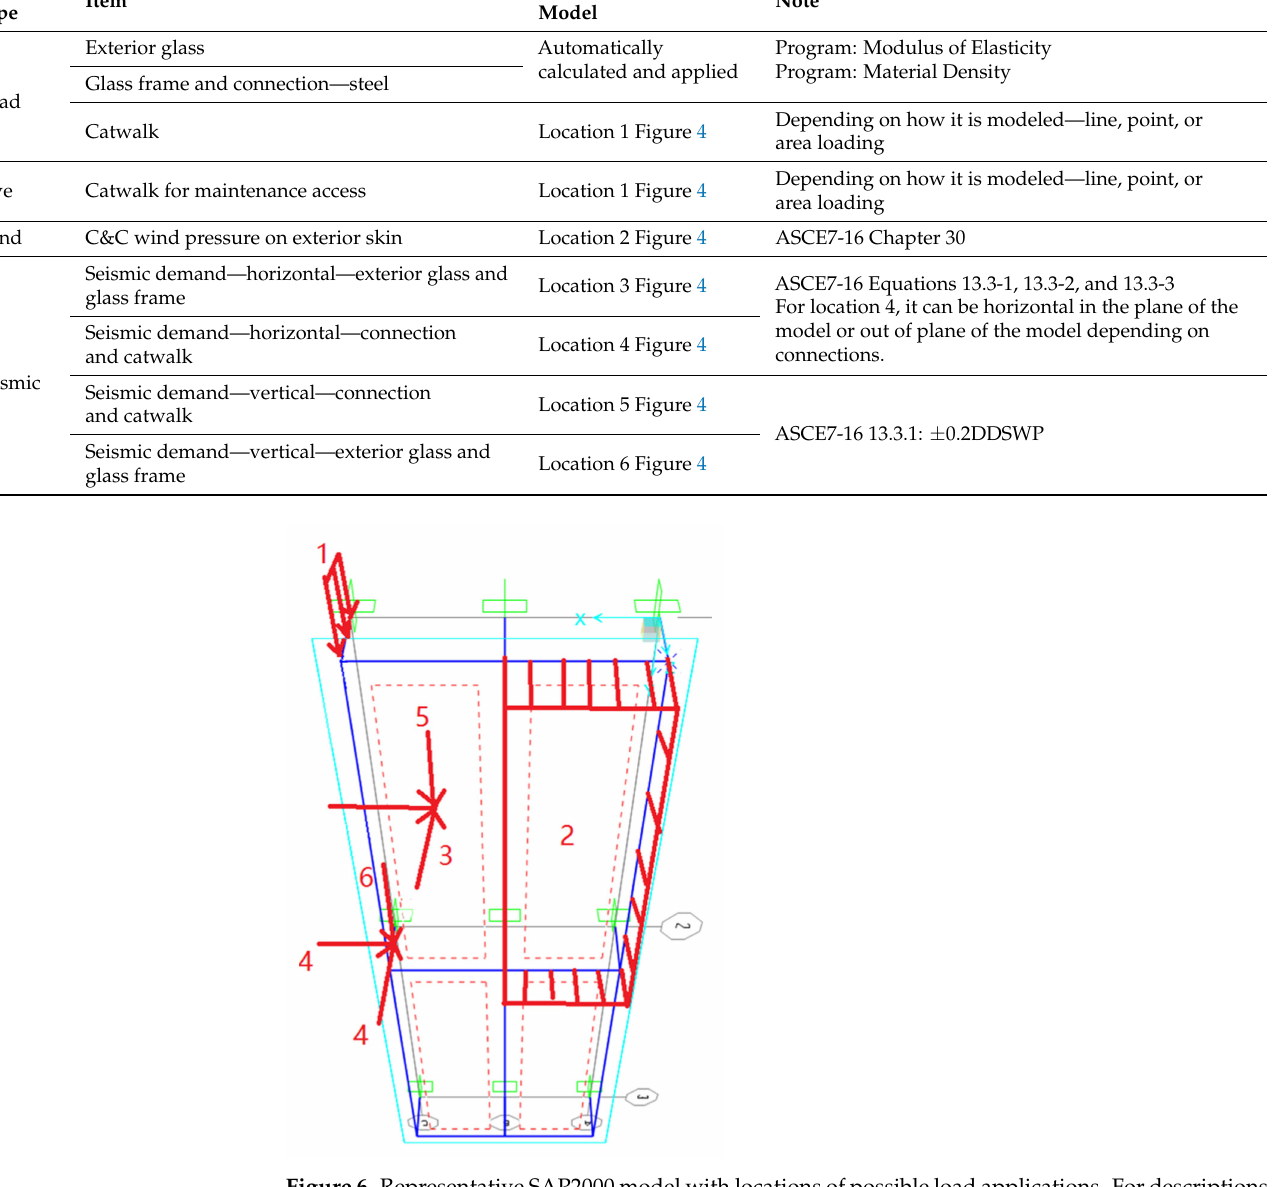
Figure 6. Representative SAP2000 model with locations of possible load applications. For descriptions of loading, please see Table